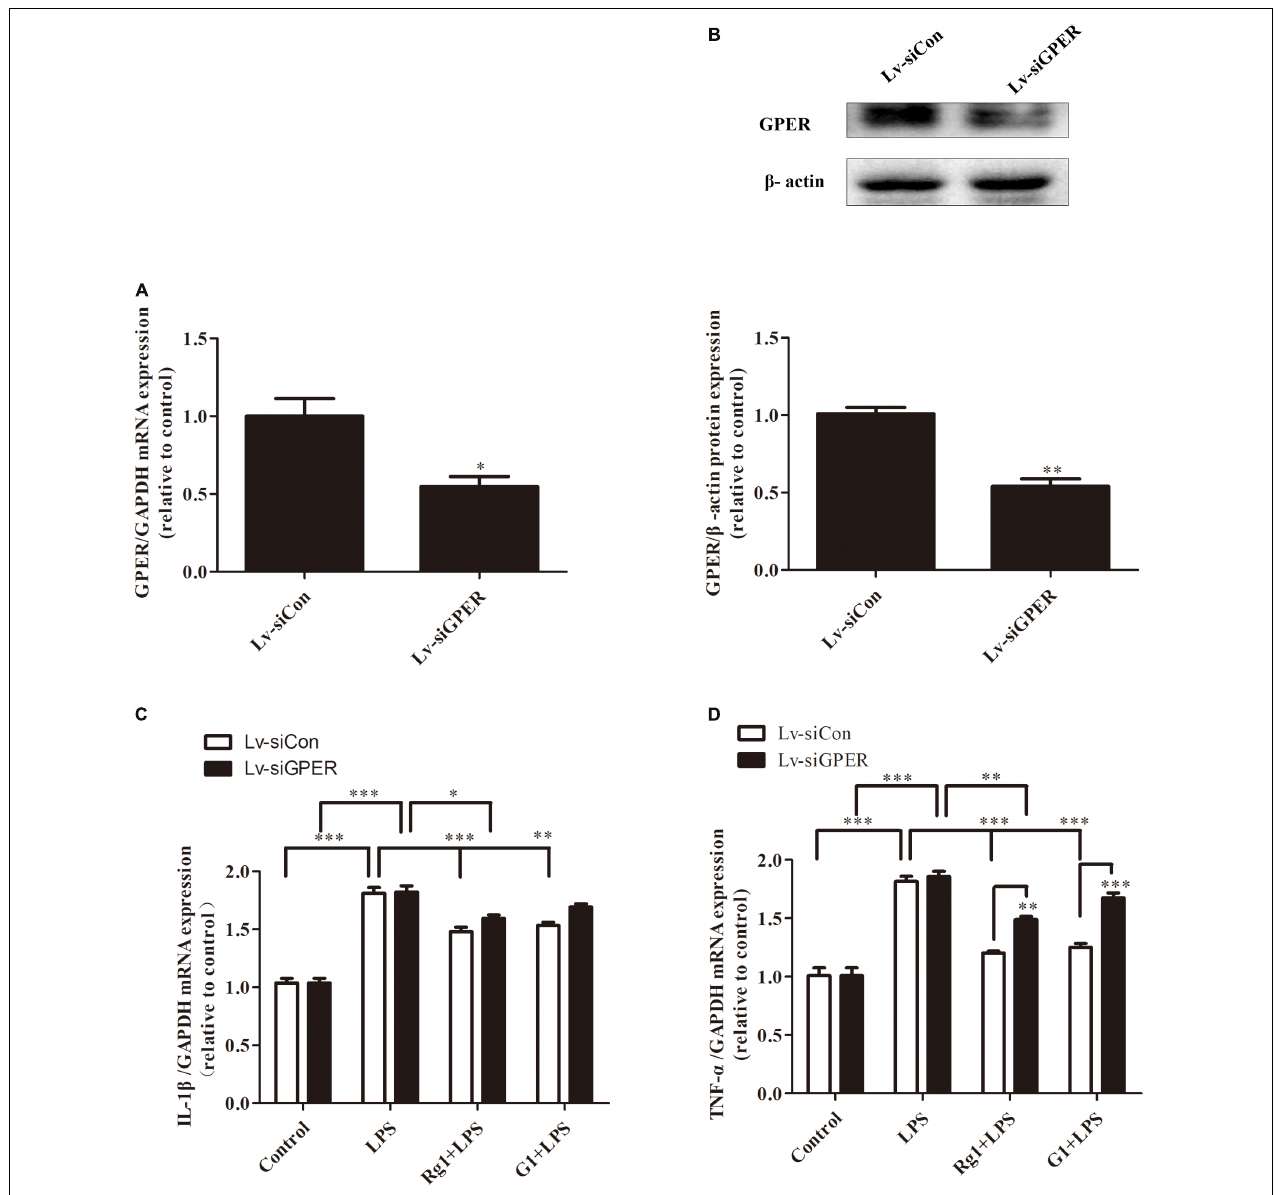
FIGURE 6 | G protein-coupled estrogen receptor gene silencing attenuated the anti-inflammatory effects of Rg1 on TNF- α and IL-1 β mRNA expression in BV2 cells. BV2 cells were infected with Lv-siCon and Lv-siGPER for 72 h separately. The mRNA and protein expression of GPER in the Lv-siCon and Lv-siGPER groups were detected by real-time PCR (A) and western blot (B) . Glyceraldehyde-3-phosphate dehydrogenase and β -actin were used as internal control. Results are expressed as the mean ± SEM, n = 3. The analyses were carried out using unpaired Student’s t -tests. ∗ P < 0.05 and ∗∗ P < 0.01 versus the control. BV2 cells were infected with Lv-siCon and Lv-siGPER for 72 h separately, followed by 10 µ M Rg1 or 1 µ M G1 for 1 h; 1 µ g ml − 1 LPS was used to stimulate the cells for 6 h, and the total RNA was collected. IL-1 β (C) and TNF- α (D) mRNA levels were measured using quantitative real-time PCR. GAPDH was used as an internal control. Results are expressed as the mean ± SEM, n = 3–5. ∗ P < 0.05, ∗∗ P < 0.01, and ∗∗∗ P < 0.001 by a two-way ANOVA followed by post hoc Bonferroni/Dunn